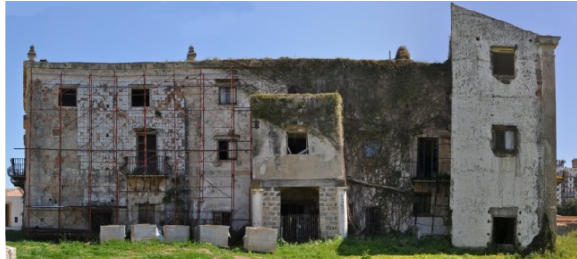
Figure 3. The state of conservation of the north-west façade.